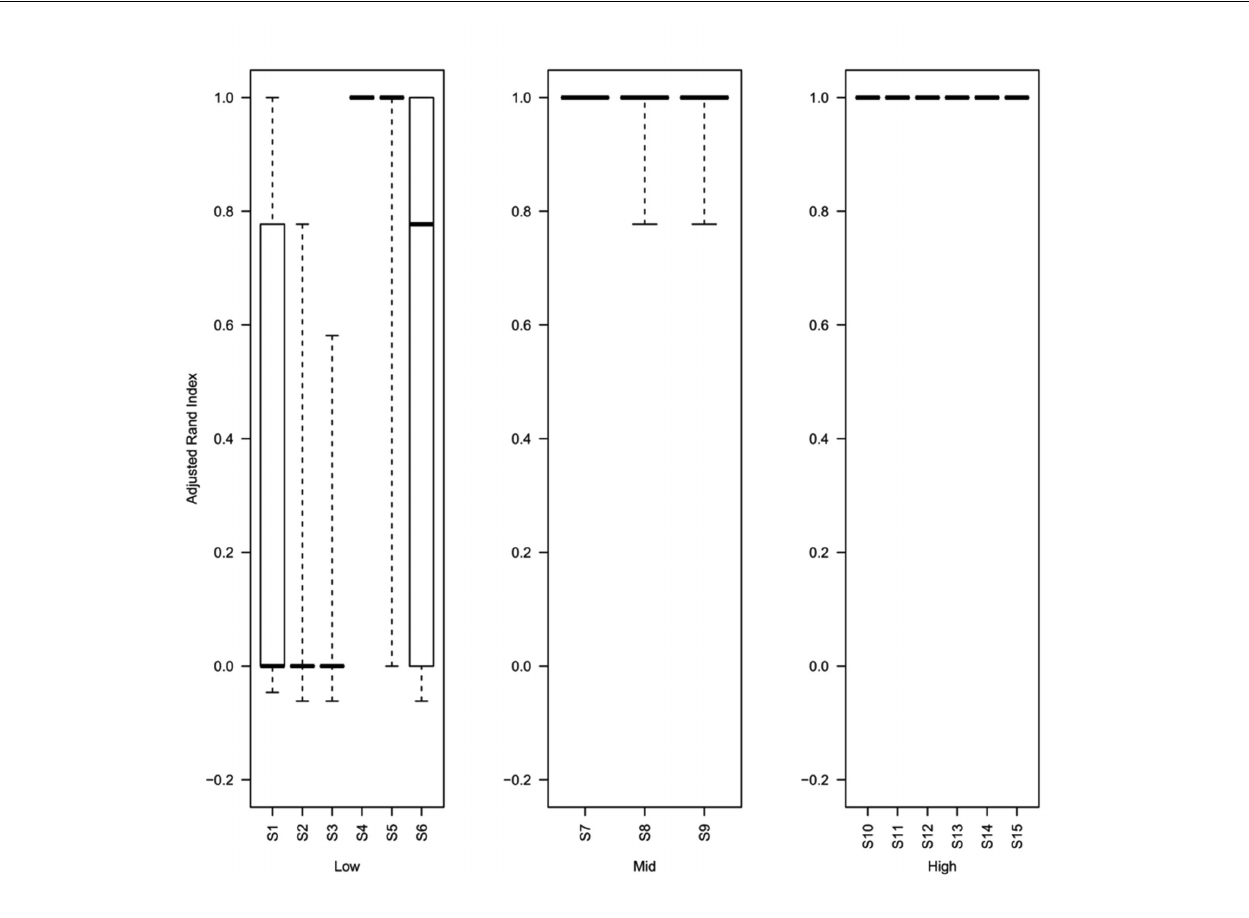
range and the whiskers mark the minimum and maximum values. For clarity the data was combined into three groups, low (0.1 and 0.5% decisive data), mid (1% decisive data), and high (5 and 10% decisive